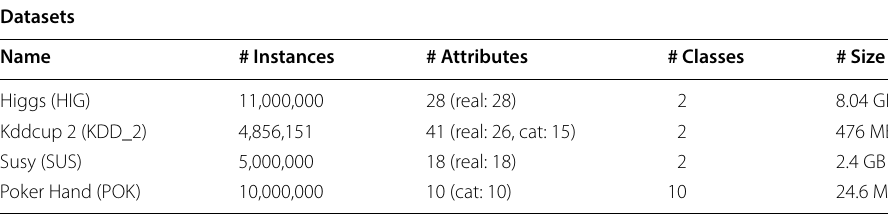
Table 2 Datasets used in the experimental comparison